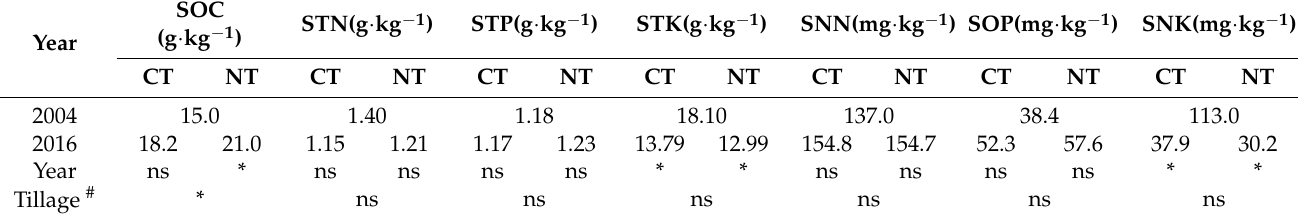
Table 1. Variation of 0–20 cm soil layer soil chemical properties between the NT and CT treatment from 2004 to 2016.